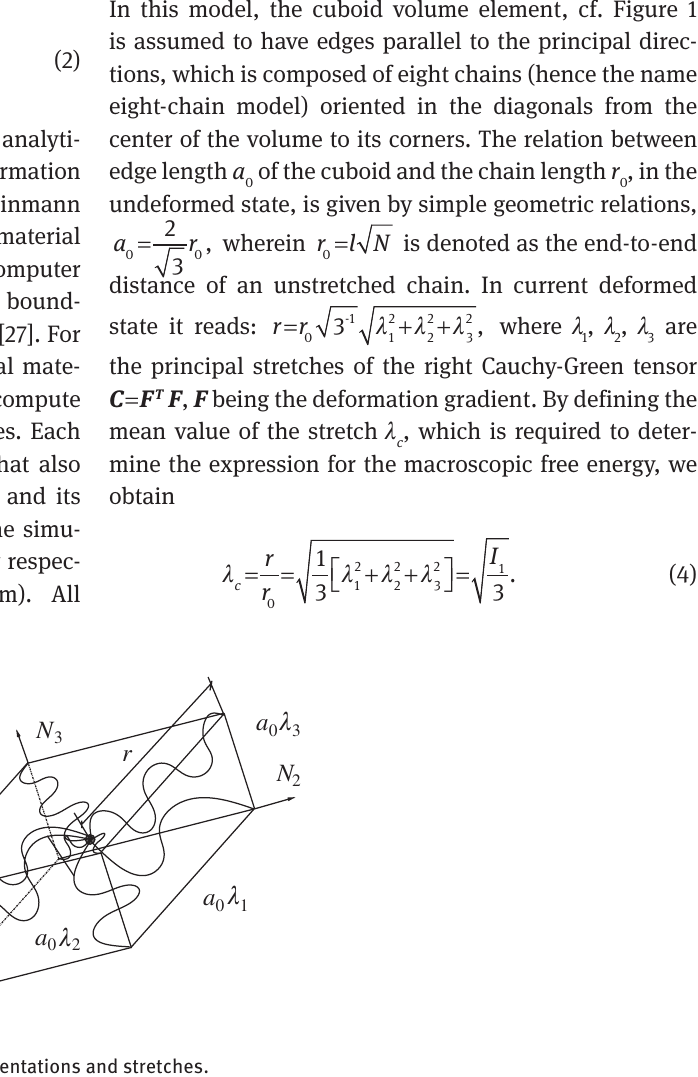
Figure 1: Eight-chain model: initial and deformed chain orientations and